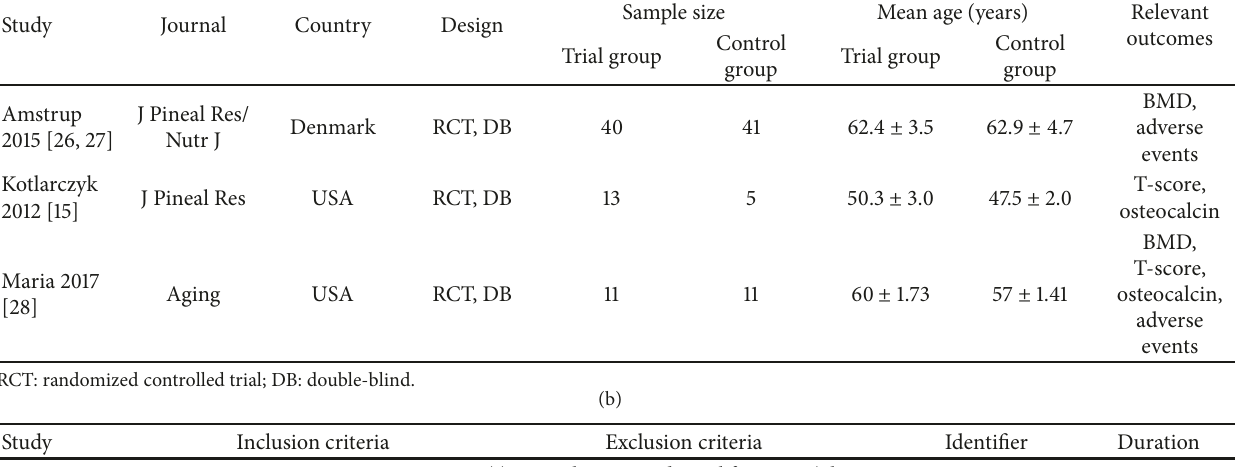
Table 2: The characteristics of the included